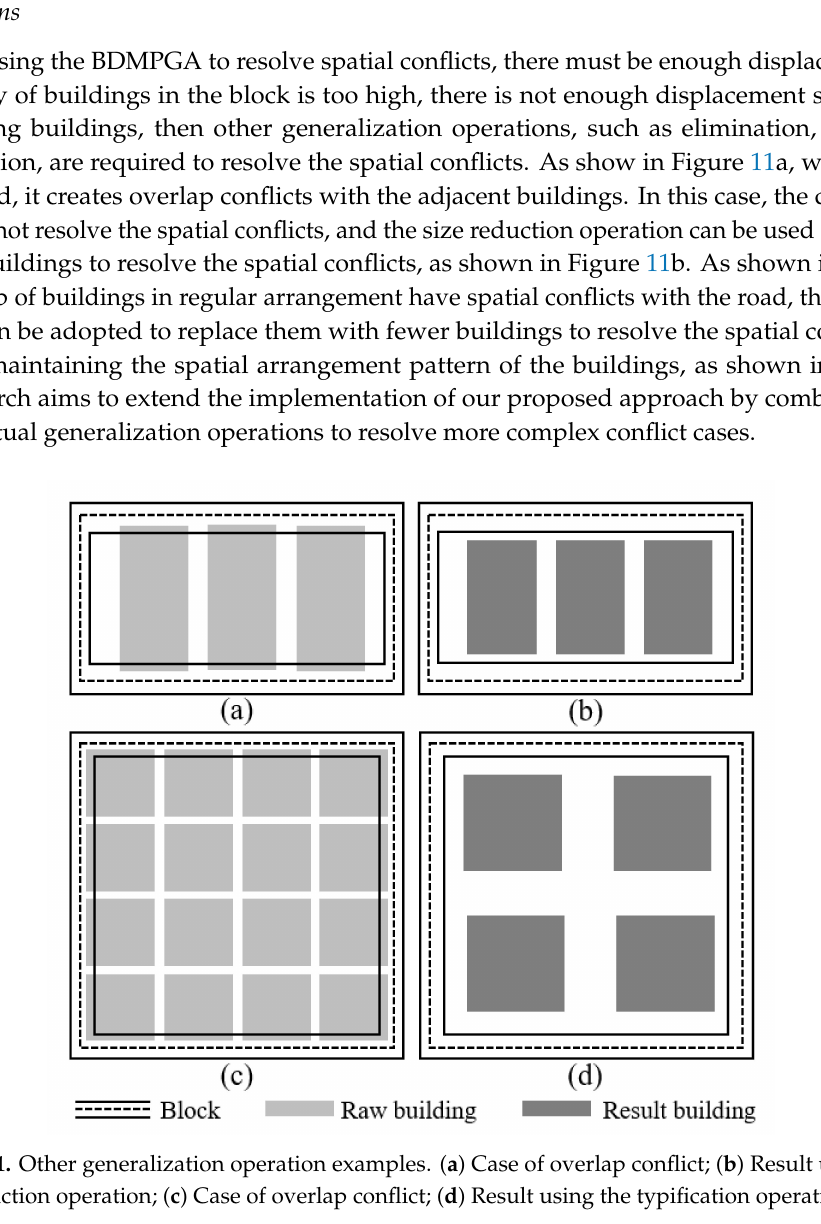
Figure 10. Comparison of the optimal fitness value in the iterative process from the three di ff erent methods. ( a – f ) Result of the optimal fitness value in the iterative process of block 1–6.